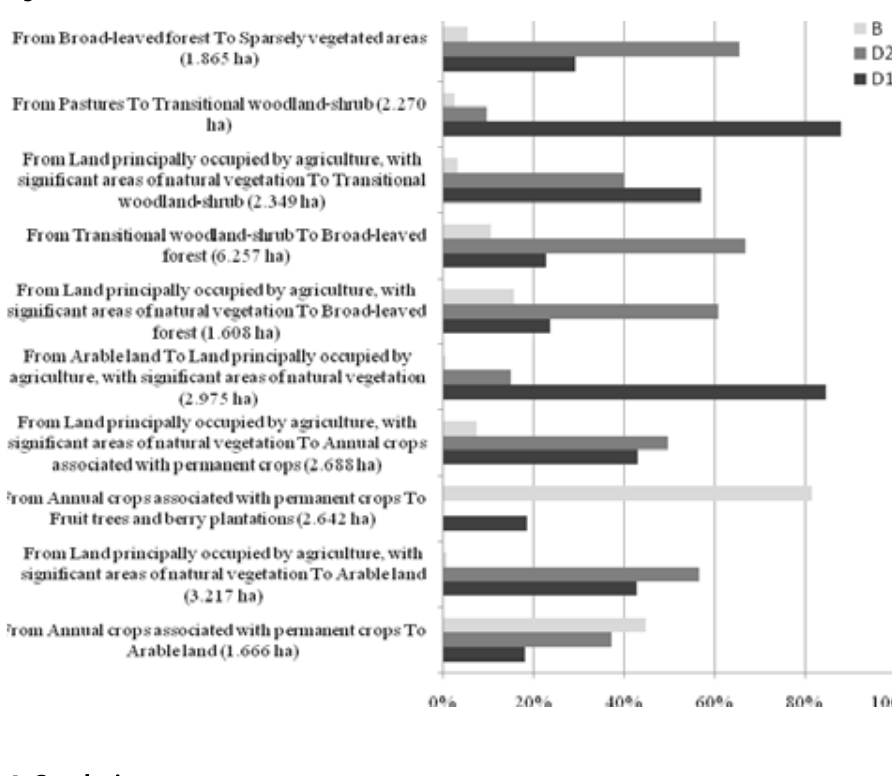
Figure 6. Distribution of “Future CAP” scenario